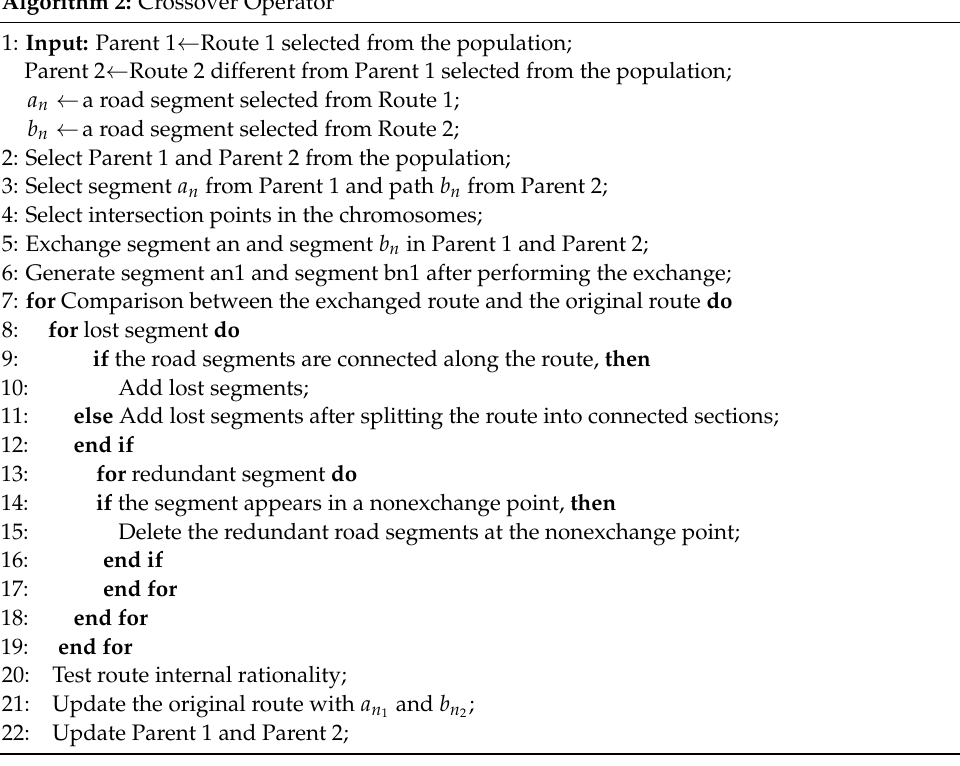
Algorithm 2: Crossover